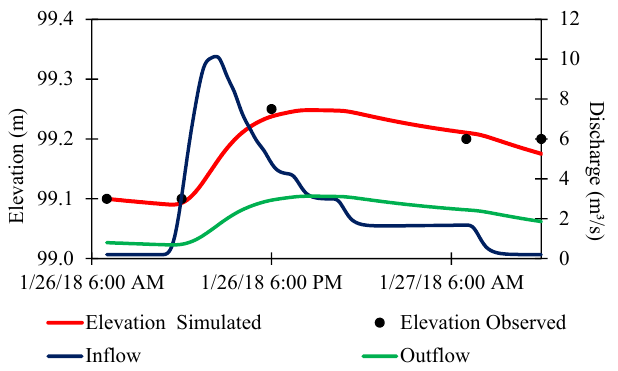
Figure 9. Calibration of CN value for the Soil Conservation Service (SCS) method with the reservoir water elevation recorded at Ketro